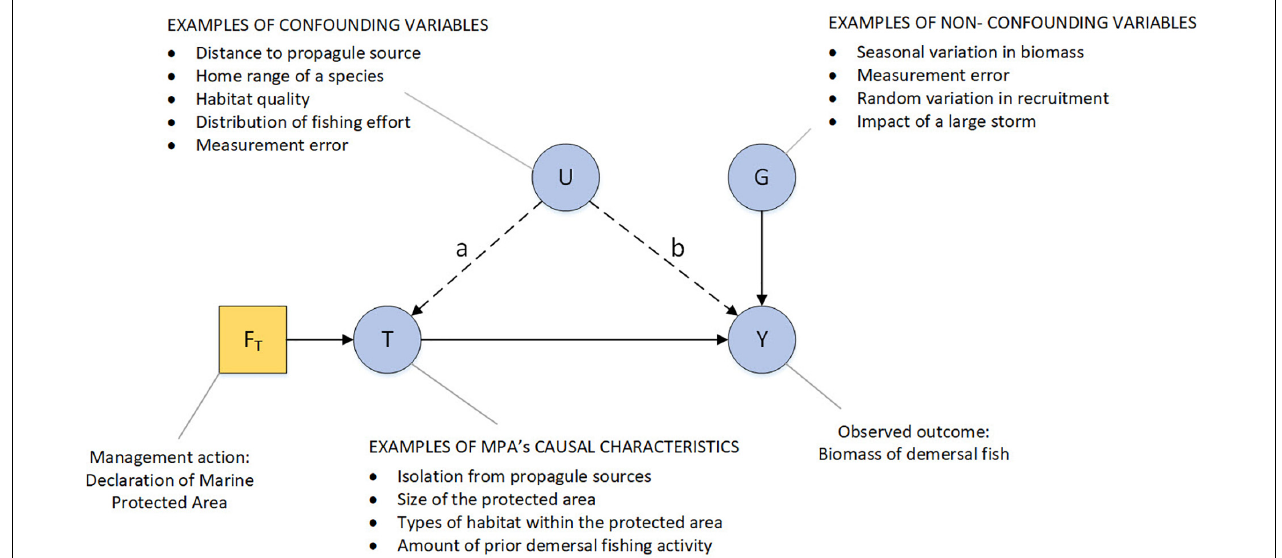
FIGURE 4 | Directed acyclic graph highlighting the effects of confounding variables on the observed effect of declaring a MPA. Single-headed arrows represent causal links. Stochastic nodes (variables) are represented by filled circles, deterministic nodes by filled squares. The node F T is the deterministic management action of declaring a no-take MPA. The resulting MPA (node T) is defined by characteristics (such as fishing effort, meta-population effects) that determine the probability of observed outcomes such as the biomass of demersal fish (node Y). A confounding variable is anything that affects both the probability of treatment (the link marked “a”) and the outcomes that the treatment is designed to alter (the link marked “b”). The effect of treatment T on outcome Y could be confounded by U if (for example) the management action is more likely to declare small MPAs, in a region isolated from propagules sources, with relatively poor habitat or in regions that have different levels of localized fishing effort inside versus outside of the proposed MPA boundaries. Monitoring programs that do not control for these variables could over- or under-estimate the effect of management. Non-confounding variables (node G), such as long term climatic shifts, are things that influence the treatment outcomes but do not influence the probability of treatment. They cause conditions inside and outside reserve boundaries to vary independently of the reserve treatment and thereby tend to reduce the power of statistical tests to detect a reserve effect. Measurement error is typically considered to be a non-confounding variable, but it can act as a confounding variable if it interacts with the treatment effect. For example, fish in a no-take zone of an MPA may be less disturbed by SCUBA observers and so more likely to be counted when compared to (spear)fished individuals outside the no-take